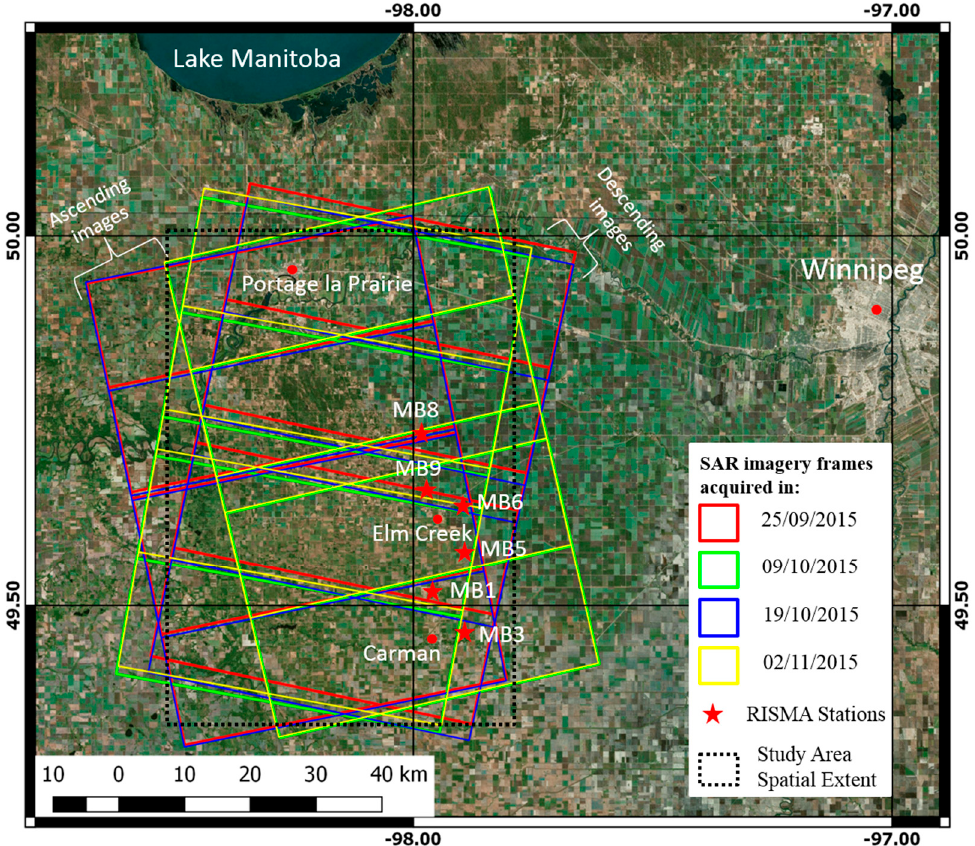
Figure 1. An aerial optical image of the location of the study area in Manitoba. The frames of each of the four dates of RADARSAT-2 SAR imagery are illustrated. Red stars indicate the locations of the Real-time In-situ Soil Monitoring for Agriculture (RISMA) stations.